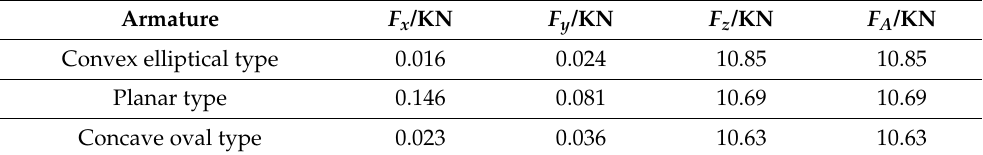
Table 3. Electromagnetic force on armatures of three configurations.